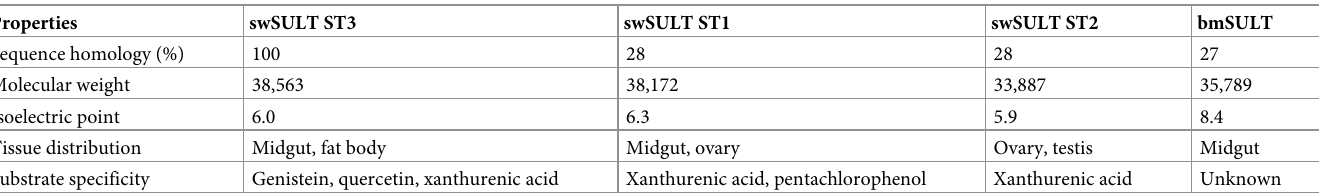
Table 1. Properties of Bombyx mori sulfotransferase (SULT) as determined by the present and previous studies [8, 9]. Properties Sequence homology (%) Molecular